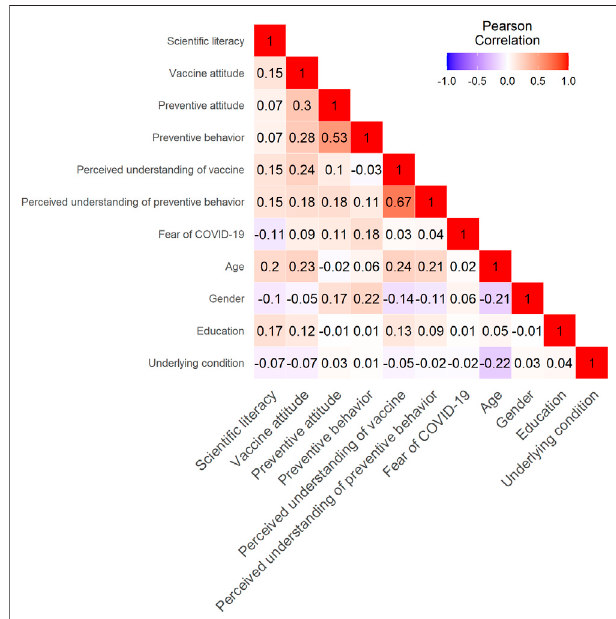
FIGURE1| Heatmapshowingzero-ordercorrelationsamongvariables.